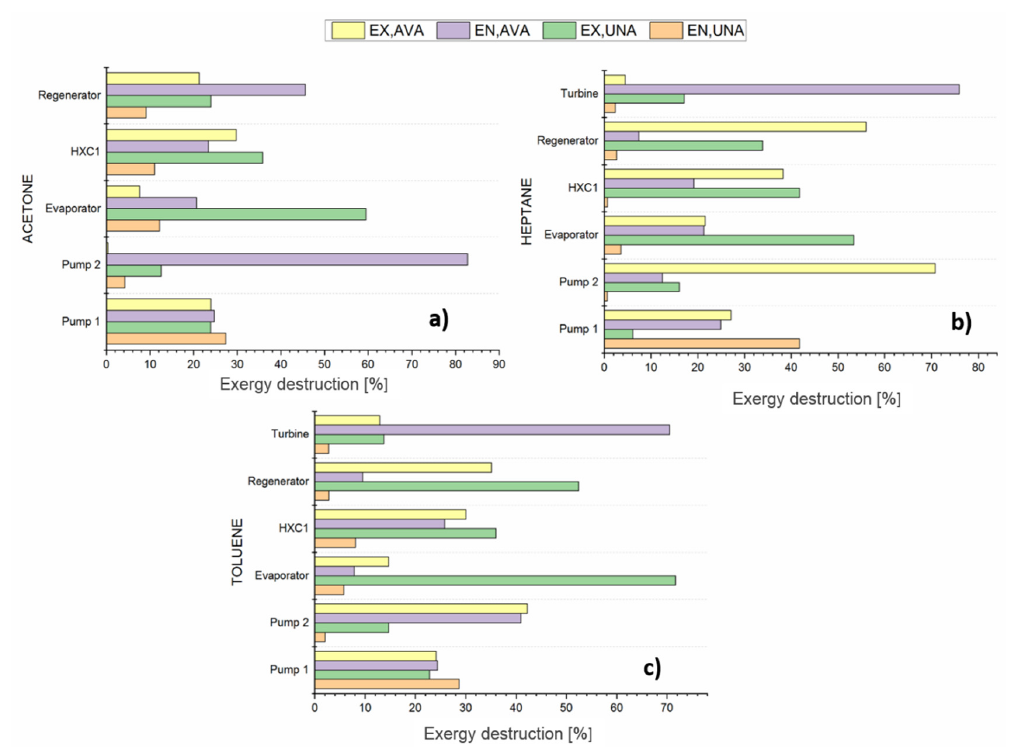
Figure 5. Disaggregation of exergy into the avoidable and unavoidable endogenous part and avoidable and unavoidable exogenous part for ( a ) acetone, ( b ) heptane, and ( c ) toluene.